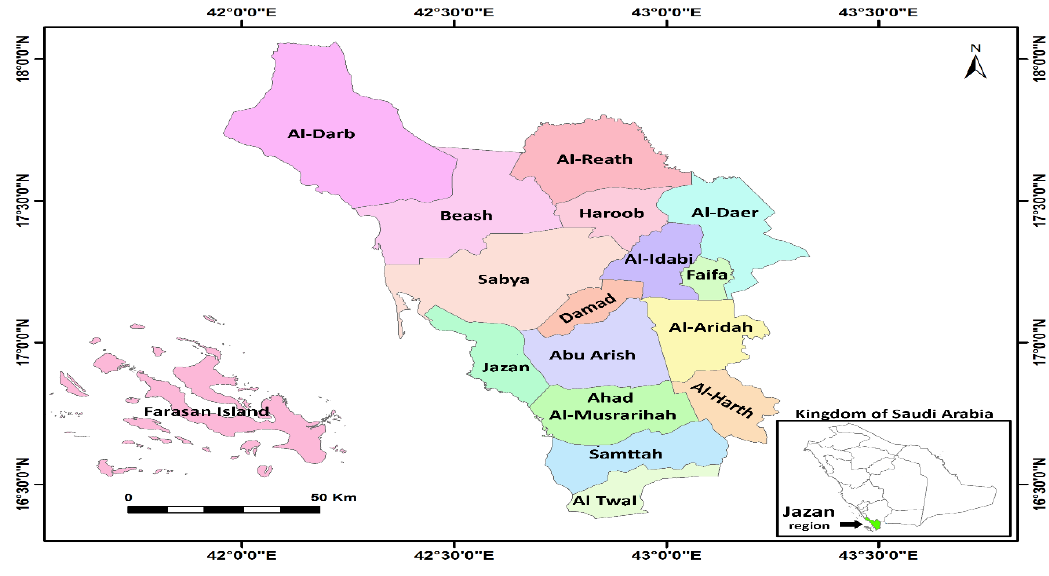
Figure 1. Map of the study area.